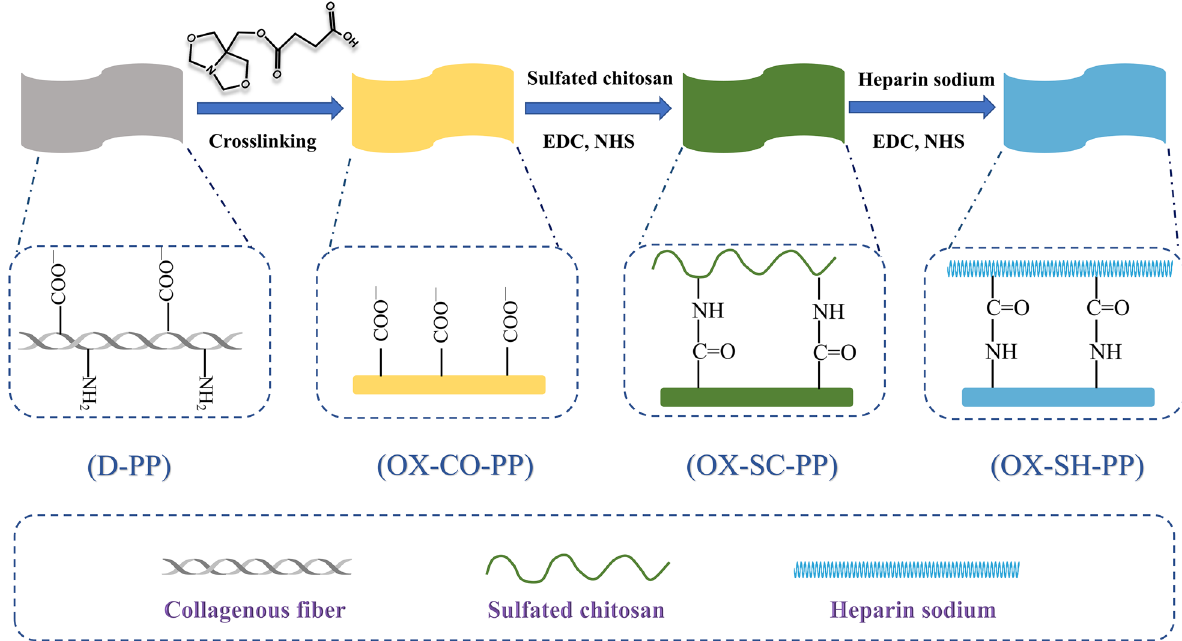
Fig. 1 The prepared route of OX-CO-PP, OX-SC-PP and